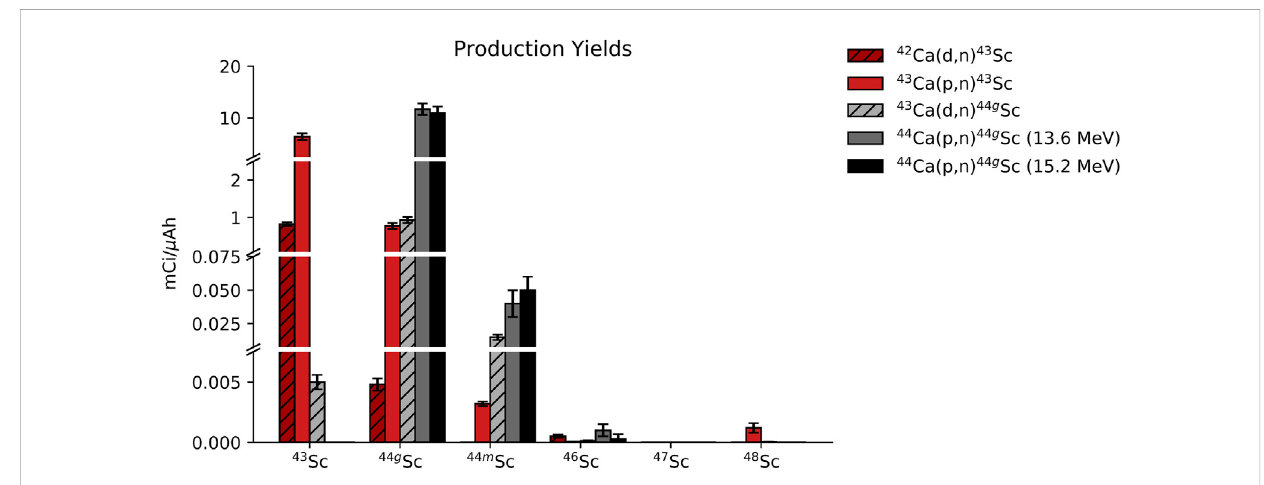
FIGURE 5 Activity of each scandium radioisotope that was present in the full target at EoB for each of the 5 reaction routes that were investigated.